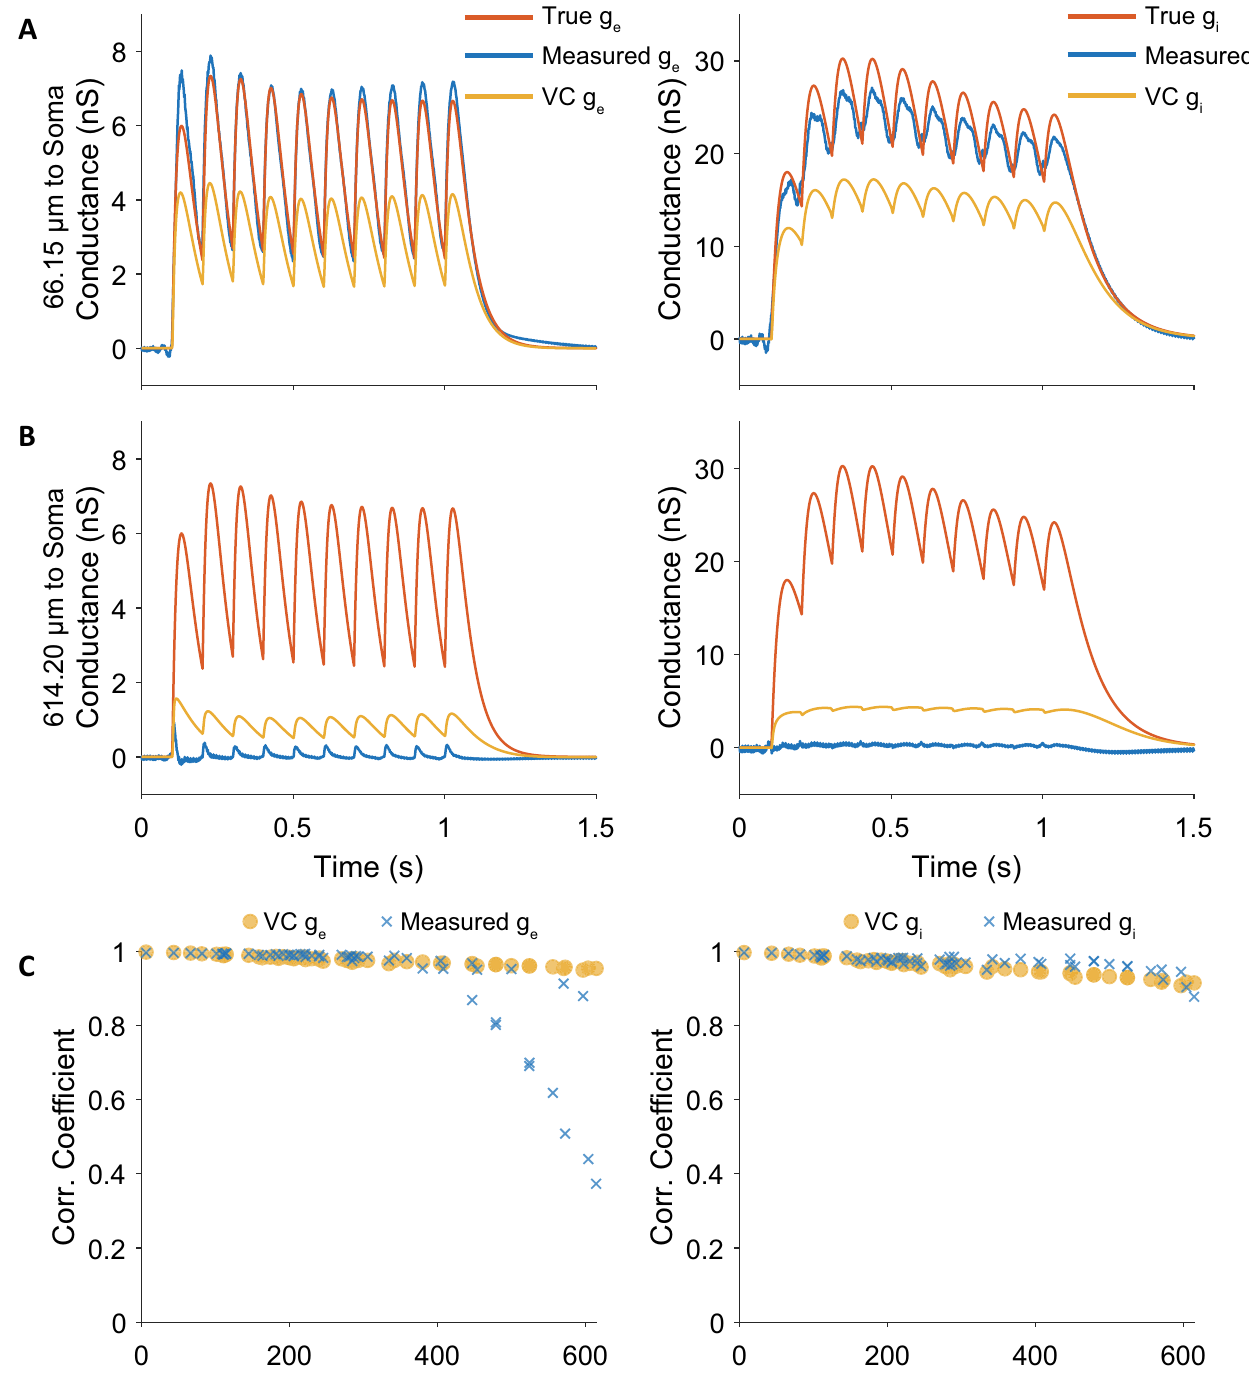
Fig 10. Simultaneous conductance measurements are accurate for synapses up to 400 μ m but break down above. A. Simultaneous conductance measurements are highly accurate for the excitatory and inhibitory proximal synapses. B. For extremely distal synapses, our simultaneous conductance measurements become inaccurate. Color legend as above. C. The correlation coefficient for many synapses confirms that simultaneous conductance measurements are at least as accurate as voltage clamp below 400 μ m somatic distance. For further away synapses, the conductance measurement technique breaks down abruptly for the excitatory